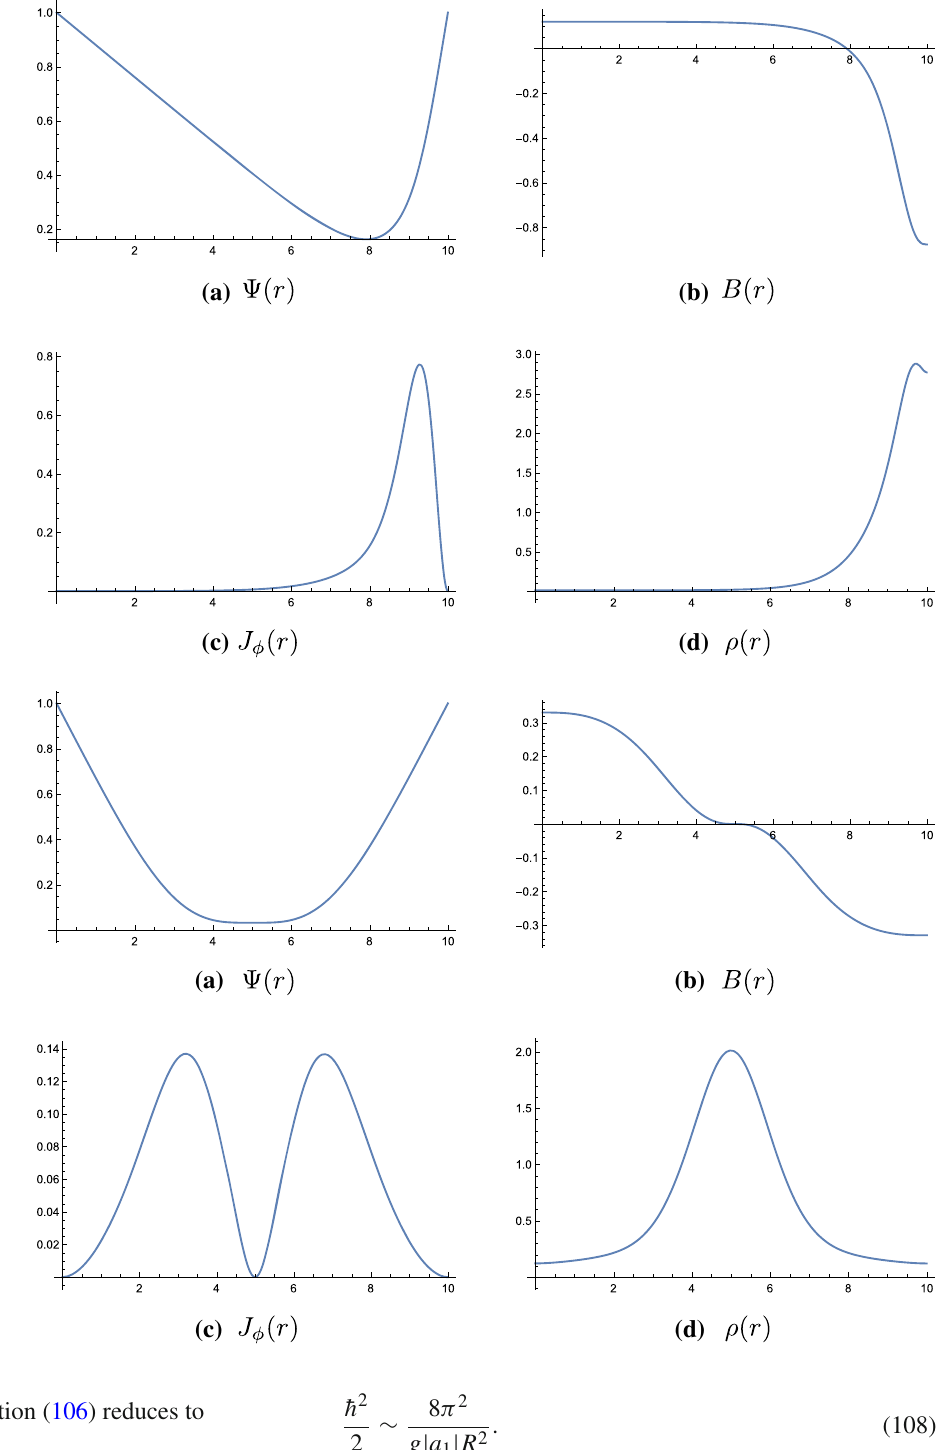
Fig. 14 Profiles for the gauged baryon solution n = 0 with non-vanishing potential a 0 = 1, using periodic boundaries for (cid:16) .